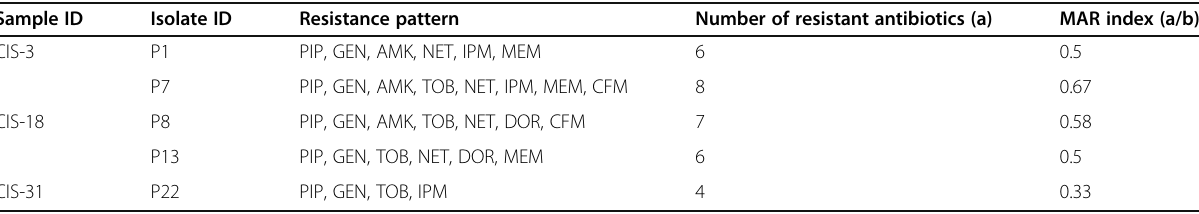
Table 1 Multiple antibiotic resistance (MAR) pattern of Pseudomonas aeruginosa isolates with MAR index values Sample